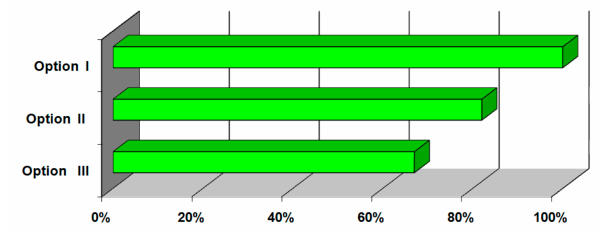
Figure 11. Percentages of the costs of works envisaged for implementation under options 1, 2,